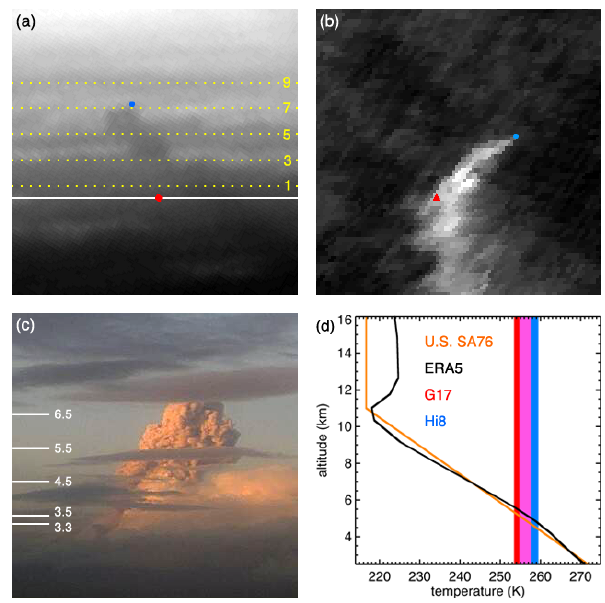
Figure 8. (a) GOES-17 band 2 fixed grid image (8 × magnification, contrast enhanced), (b) Himawari-8 band 3 CEReS V20190123 im- age (contrast enhanced), and (c) Klyuchi webcam image of the 30 August 2019 eruption of Sheveluch at 08:00UTC. The red di- amond/triangle marks the volcano base, and the blue dots indicate the same plume top element in the satellite images. In panel (a) , the baseline (solid white) and the odd number isoheights (in km, dotted yellow) are also drawn. In panel (c) , the white markings indicate height in kilometers. Panel (d) shows the ERA5 temperature pro- file (black line), the U.S. Standard Atmosphere 1976 temperature profile (orange line), and the range of the GOES-17 and Himawari- 8 minimum BT 11 between 08:00–09:00UTC (red and blue shaded areas, overlap in